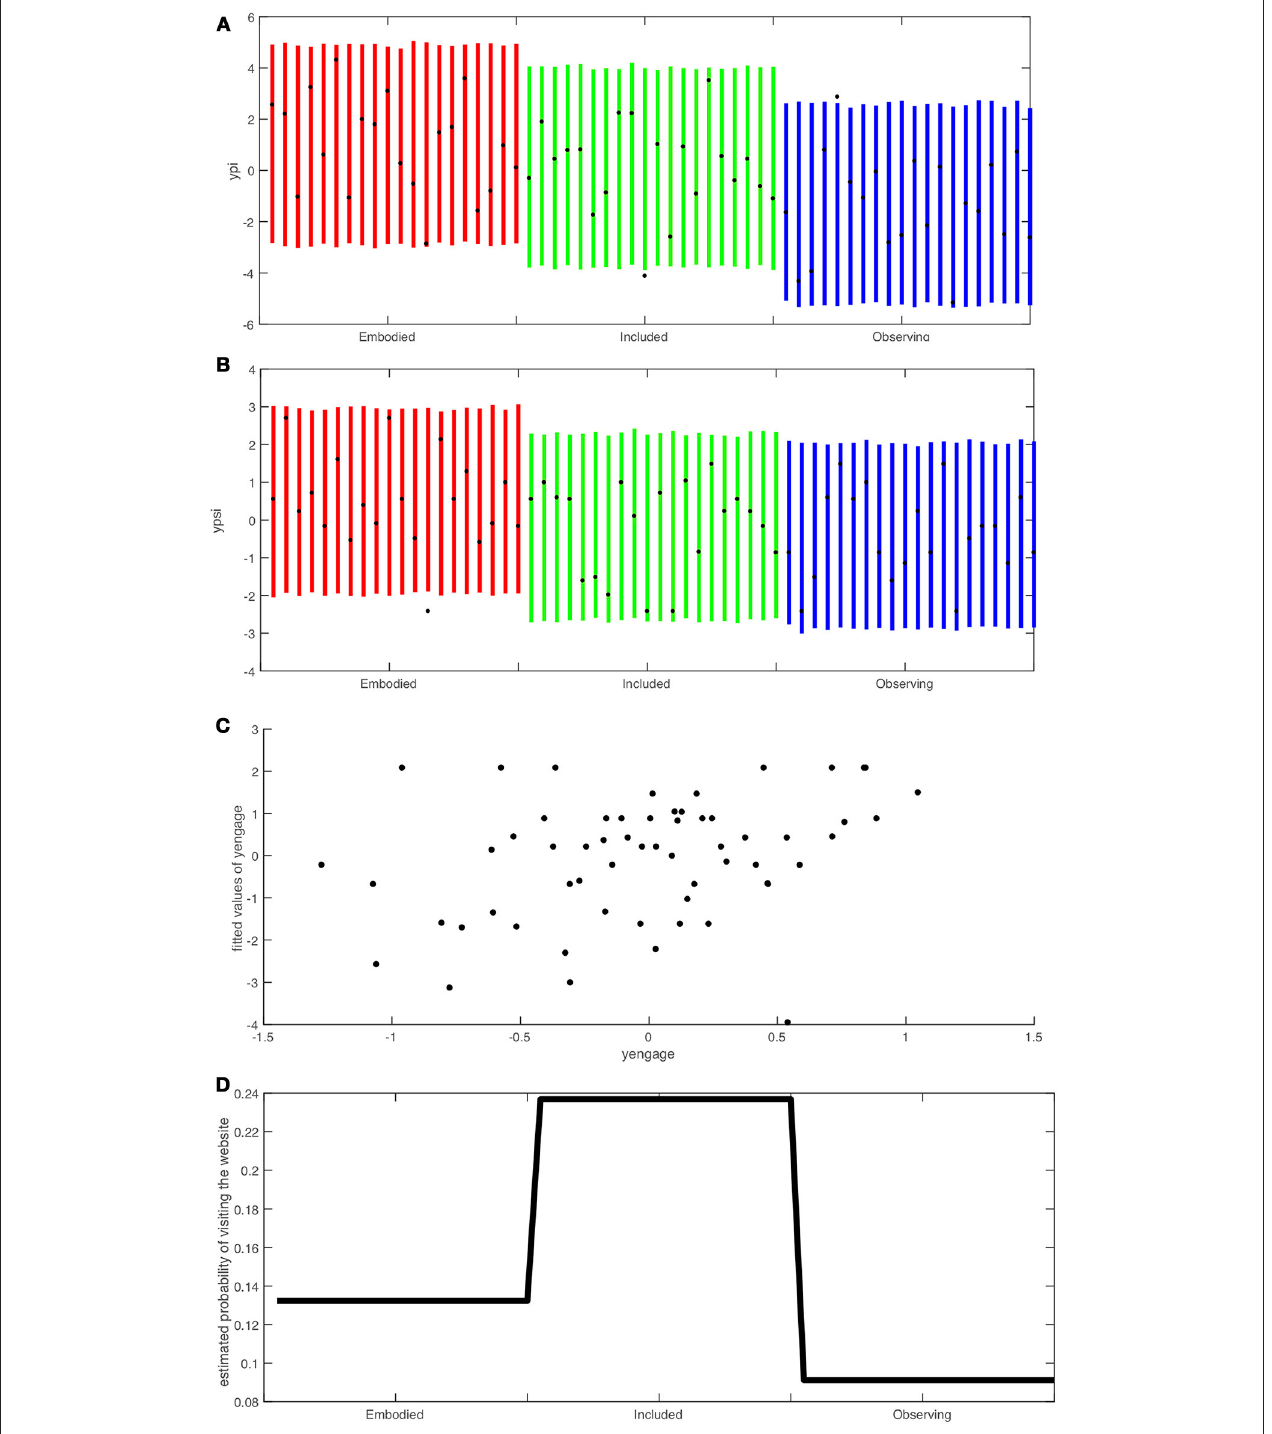
FIGURE 8 | Credible intervals and fitted values of the model corresponding to Equations (1)–(4) and Table 2 . (A) Credible intervals for the ypi scores of each individual with the black dots the observed values, separated into Embodied, Included and Observing conditions. (B) Credible intervals for the ypsi scores of each individual with the black dots the observed values, separated into Embodied, Included and Observing conditions. (C) Fitted values of yengage by observed values. (D) Probabilities of the website follow-up by Embodied, Included, and Observing conditions.